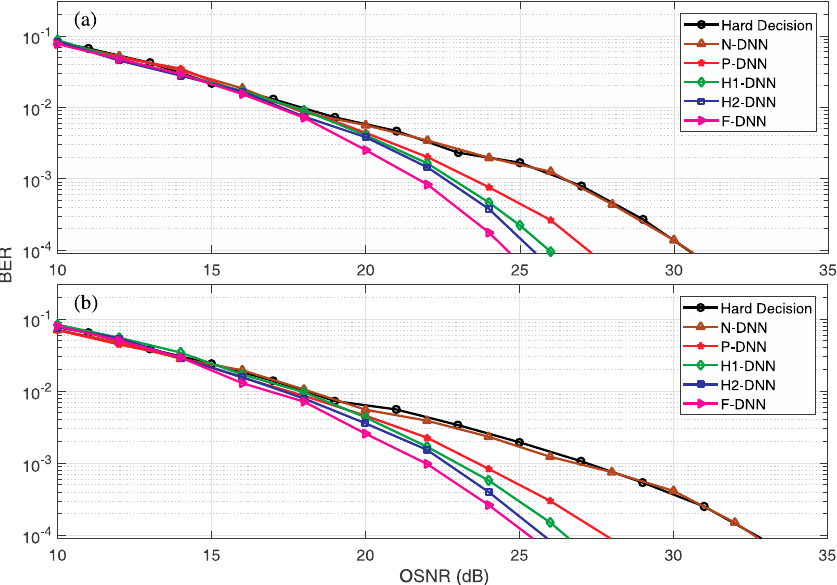
Figure 19. ICI cancellation using NNs. ( a ) B2B (back-to-back) case. ( b ) 80 km fiber transmission.